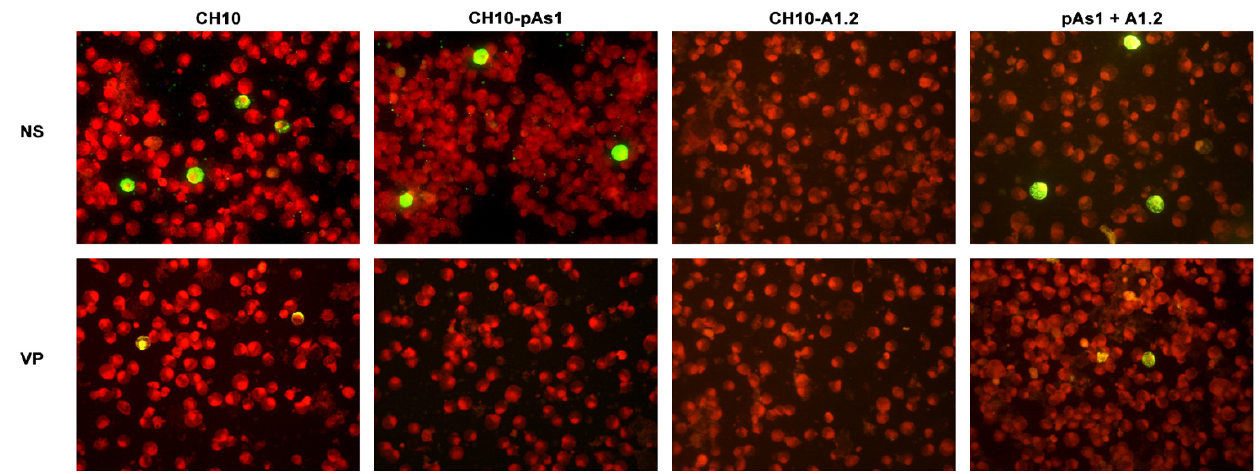
Figure 8. UT7/EpoS1 cells transfected with the indicated inserts were sampled at 24 hpt, and NS1 or VP1/2 proteins were detected by IIF. Results obtained for insert CH10-A1.1 were analogous to what obtained for CH10-A1.2 (not in figure). Original magnification 400×.